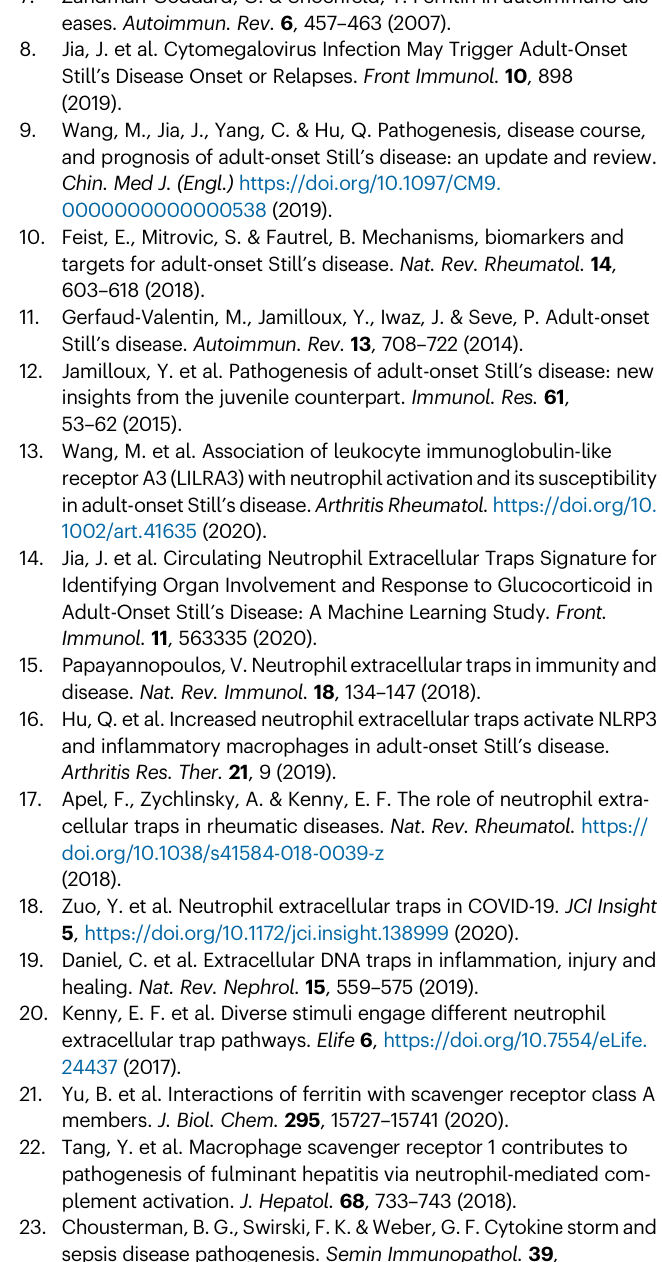
Fig. 8 | Hyperferritinemia contributes to increased NET formation in AOSD patients.a ThecorrelationsbetweenserumferritinlevelsandcirculatingNET-DNA complexes and cell-free DNA levels in AOSD patients ( n =64). b Ferritin (FTH) in serafrom 3 patients with active AOSD waseitherabsorbed away(afterabsorption) or not absorbed (before absorption), and then measured by Western blotting. Quanti fi cation of cell-free DNA and MPO-DNA complexes released by neutrophils from healthy donors stimulated with sera above. Plots show means±SD from one representative experiment with n =3 technical replicates. Results were con fi